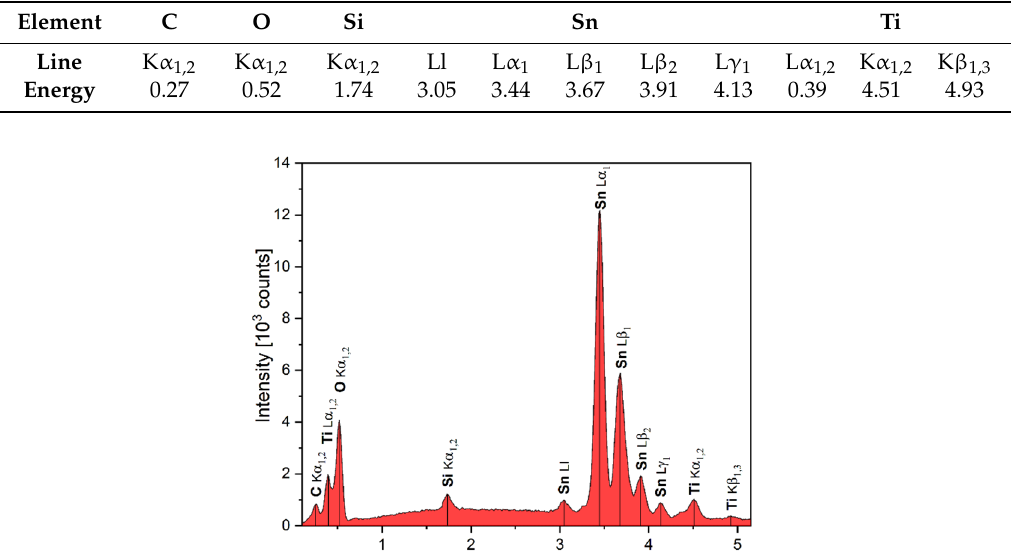
Figure 3. EDS spectrum of the TiO 2 /FTO/glass stack. Characteristic lines are tabulated in Table 1. Table 1. Characteristic lines received from the EDS spectrum of the TiO 2 /FTO/glass stack with energies in keV.